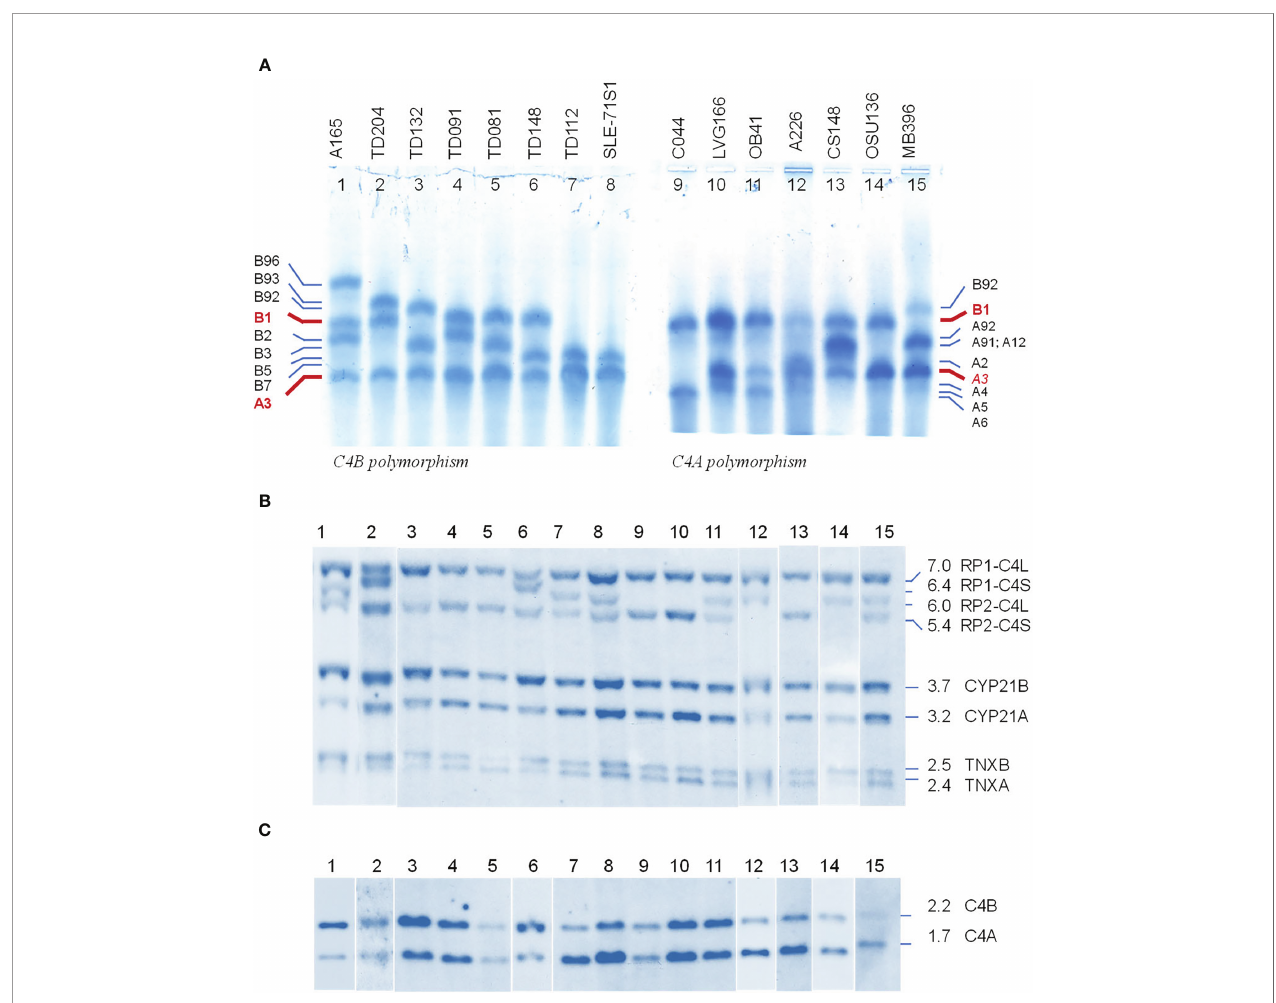
FIGURE 2 | Polymorphic variants, RCCX modules and gene copy number variations of human complement C4B and C4A - from phenotypes to genotypes. (A) Polymorphisms of C4 protein. EDTA-plasma from 15 human subjects were treated with neuraminidase and carboxypeptidase B, subjected to high voltage agarose gel electrophoresis to resolve C4 plasma proteins based on gross differences in electric charge, immuno fi xed with goat antiserum against human C4, blotted to remove diffusible proteins and then stained. The most common form of C4 allotypes are B1 and A3 (red fonts). The left of panel (A) showed common variants of C4B. The right of panel (A) showed common variants of C4A. Band intensities in each lane re fl ected the relative expression levels of various protein allotypes. (B) Taq I restriction fragment length polymorphism (RFLP) of DNA samples from the same subjects to demonstrate RCCX modular variations. (C) Psh AI- Pvu II RFLP to elucidate the relative dosage of C4B and C4A genes. Please refer to of Figure 1F for interpretation of long and short C4 genes in linkage with RP1 or RP2 . De fi nitive assignments of C4A and C4B protein allotypes in each subject often require parallel genotyping experiments to determine RCCX modular variations and C4A and C4B gene copy numbers as shown